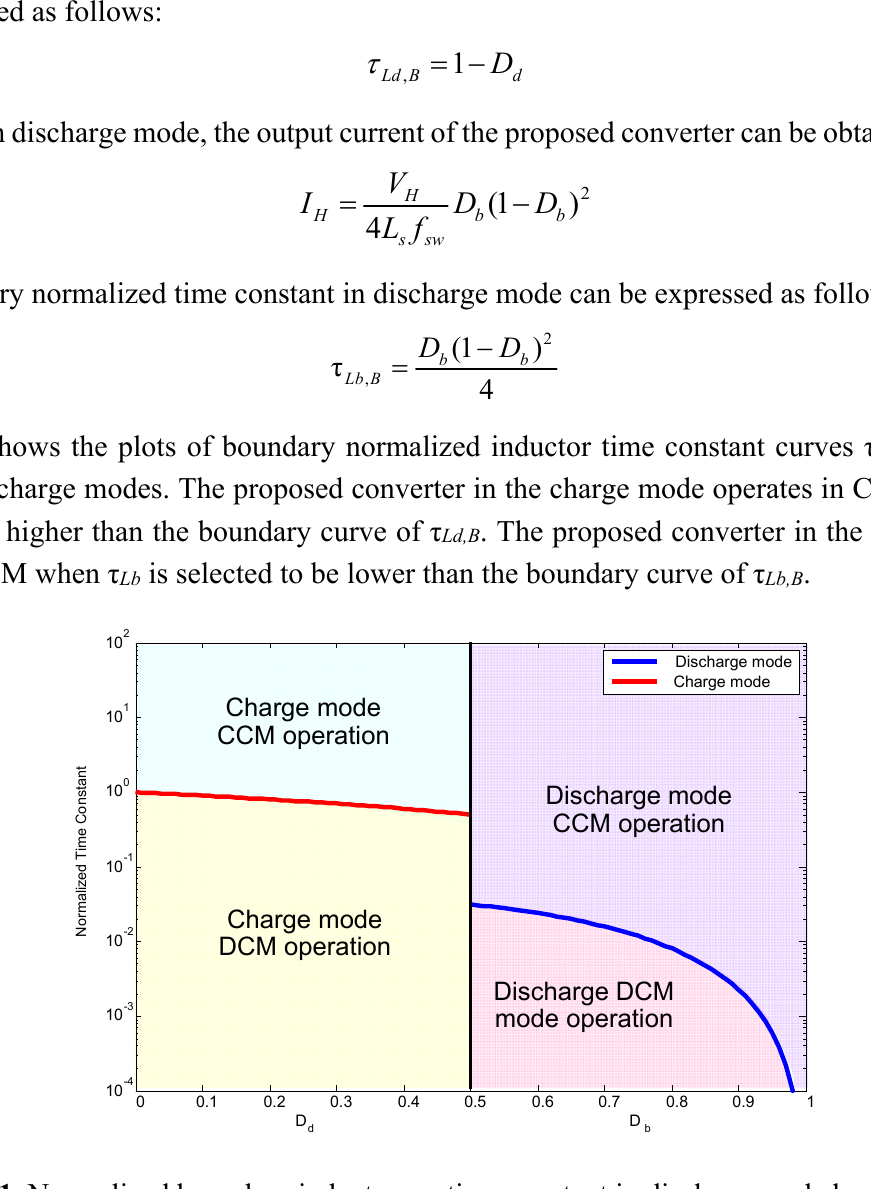
Figure 11. Normalized boundary inductances time constant in discharge and charge